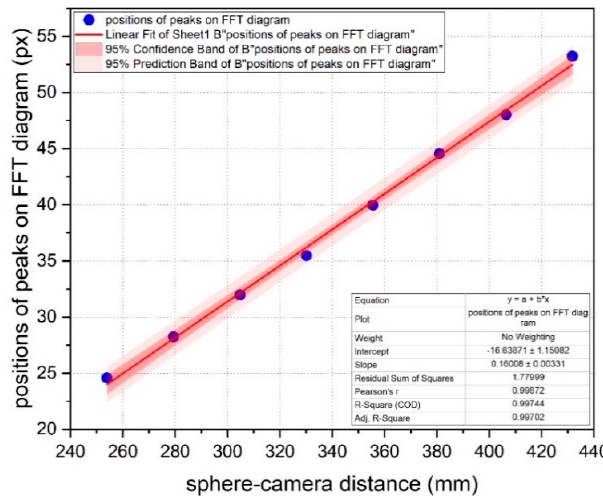
Figure 26. Average spacing (in pixel) of the bright bands of the polar back scattered image of the sphere; the spacing of the bright rings of the cartesian image is connected to the vertical bands spacing through a factor k dependent on the resolution of the original image.